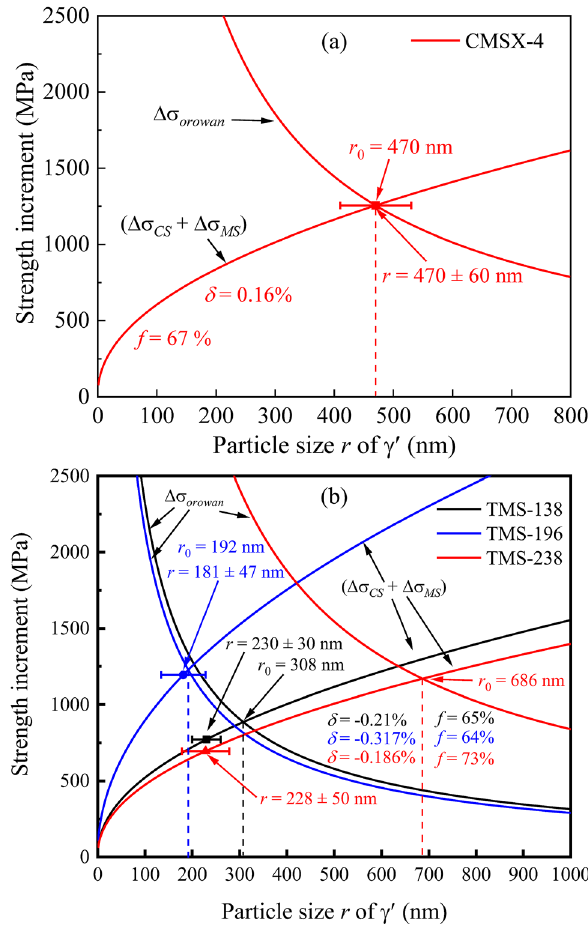
Figure 2. Computations of (Δσ CS + Δσ MS ) and Δσ orowan as a function of particle size r of γ ′ for the CMSX-4 ( a ) and TMS-138, TMS-196, and TMS-238 superalloys ( b ), in which the optimal particles sizes ( r 0 ) and the experimentally-measured r values, as well as the volume fraction f of γ ′ precipitates are also marked for each